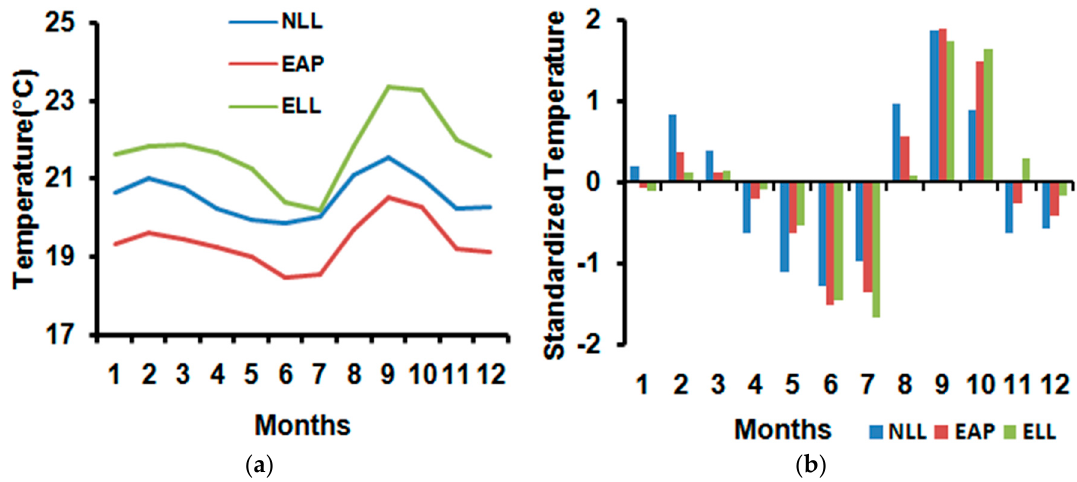
Figure 2. Monthly ( a ) temperature patterns; ( b ) standardized temperature at Northern lowlands of Bugesera (NLL), Eastern arid plateaus (EAP), and The Eastern lowlands of Kumoso (ELL).